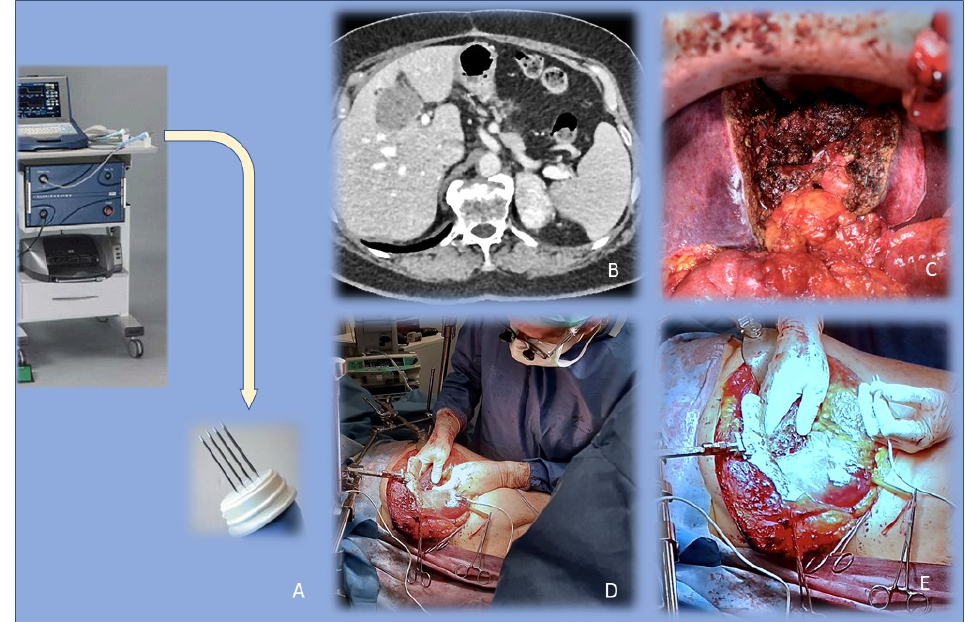
Figure 1. Electrochemotherapy (ECT) of deep-seated tumors. ( A ) equipment for intraoperative electroporation with magnified image of electrodes; ( B ) a large hilar cholangiocarcinoma, whose surgical complete removal was unlikely; ( C ) surgery was performed to remove all the macroscopical tumor burden; ( D , E ) chemoelectroporation was performed upon the perihilar liver tissue to improve the chance of cure.